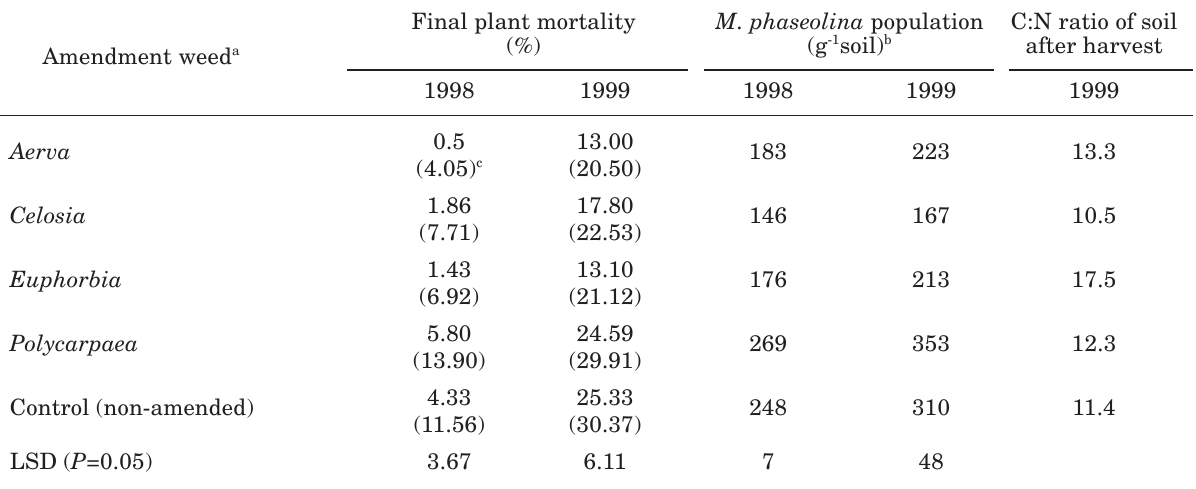
Table 2. Field effectiveness of weed residues as a soil amendment on plant mortality from dry root rot on clusterbean in 2-years